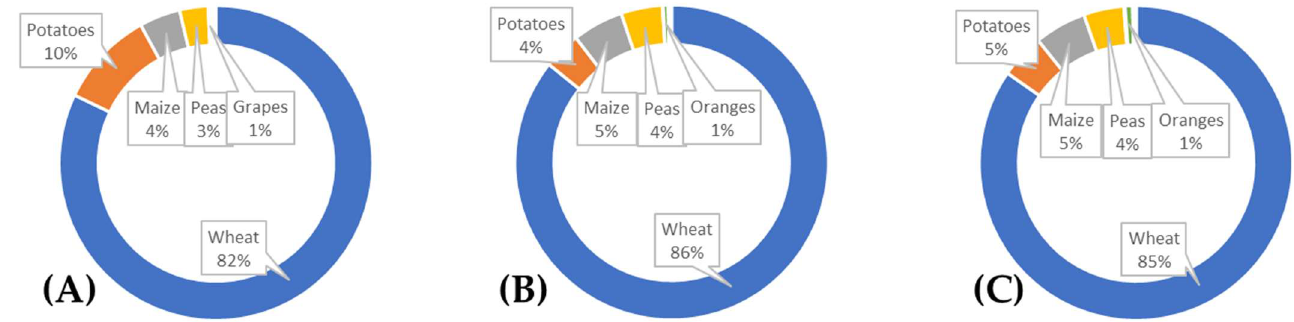
Figure 11. Imports of Sri Lanka during 2010–2020: ( A ) total quantities, ( B ) virtual water, ( C ) virtual land for top ten crops.